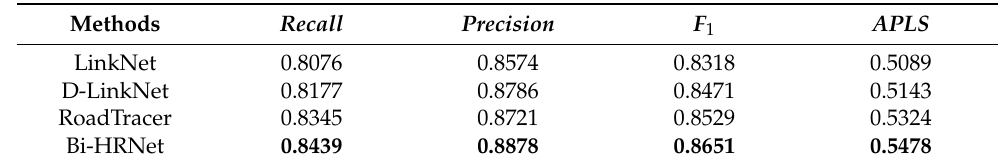
Table 1. Comparison of LinkNet, D-LinkNet, RoadTracer, and the proposed Bi-HRNet on the DeepGlobe dataset.